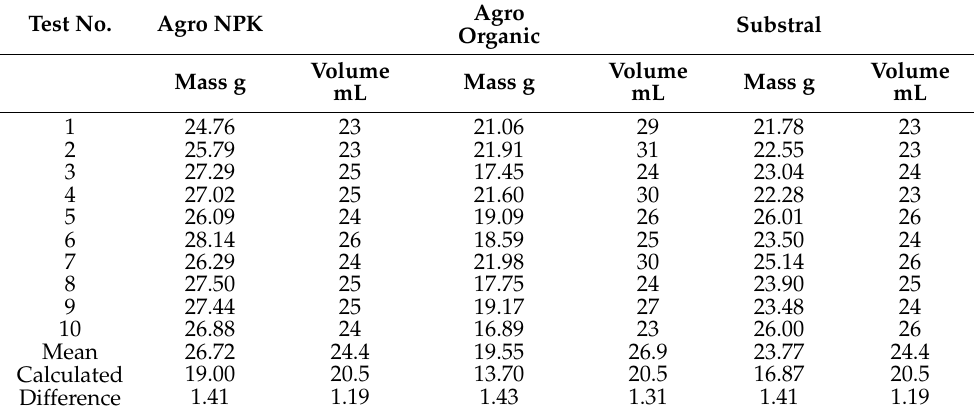
Table 6. Dosing results at one full revolution of the grooved roller. Test